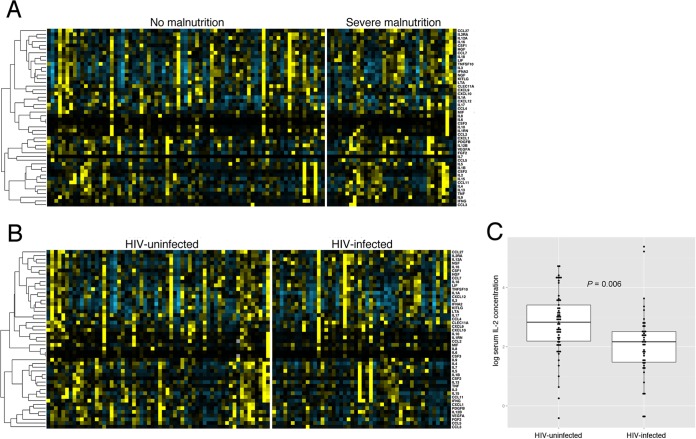
Serum cytokine responses to acute iNTS disease in African children with HIV infection and malnutrition. (A) Heat map of 48 serum cytokine concentrations during acute iNTS disease in children with (right; n = 27) and without (left; n = 73) severe malnutrition. (B) Heat map of 48 serum cytokine concentrations during acute iNTS disease in children with (right; n = 47) and without (left; n = 59) HIV coinfection. Yellow color change represents increased cytokine concentration relative to the median for all samples, and blue color change represents a decrease. Cytokines are ordered by unsupervised hierarchical clustering, with between-cytokine distances represented by the dendrogram on the left side of the heat map. (C) Serum IL-2 concentration (log transformed) in acute iNTS disease in uninfected (left; n = 47) and HIV-infected (right; n = 59) children.